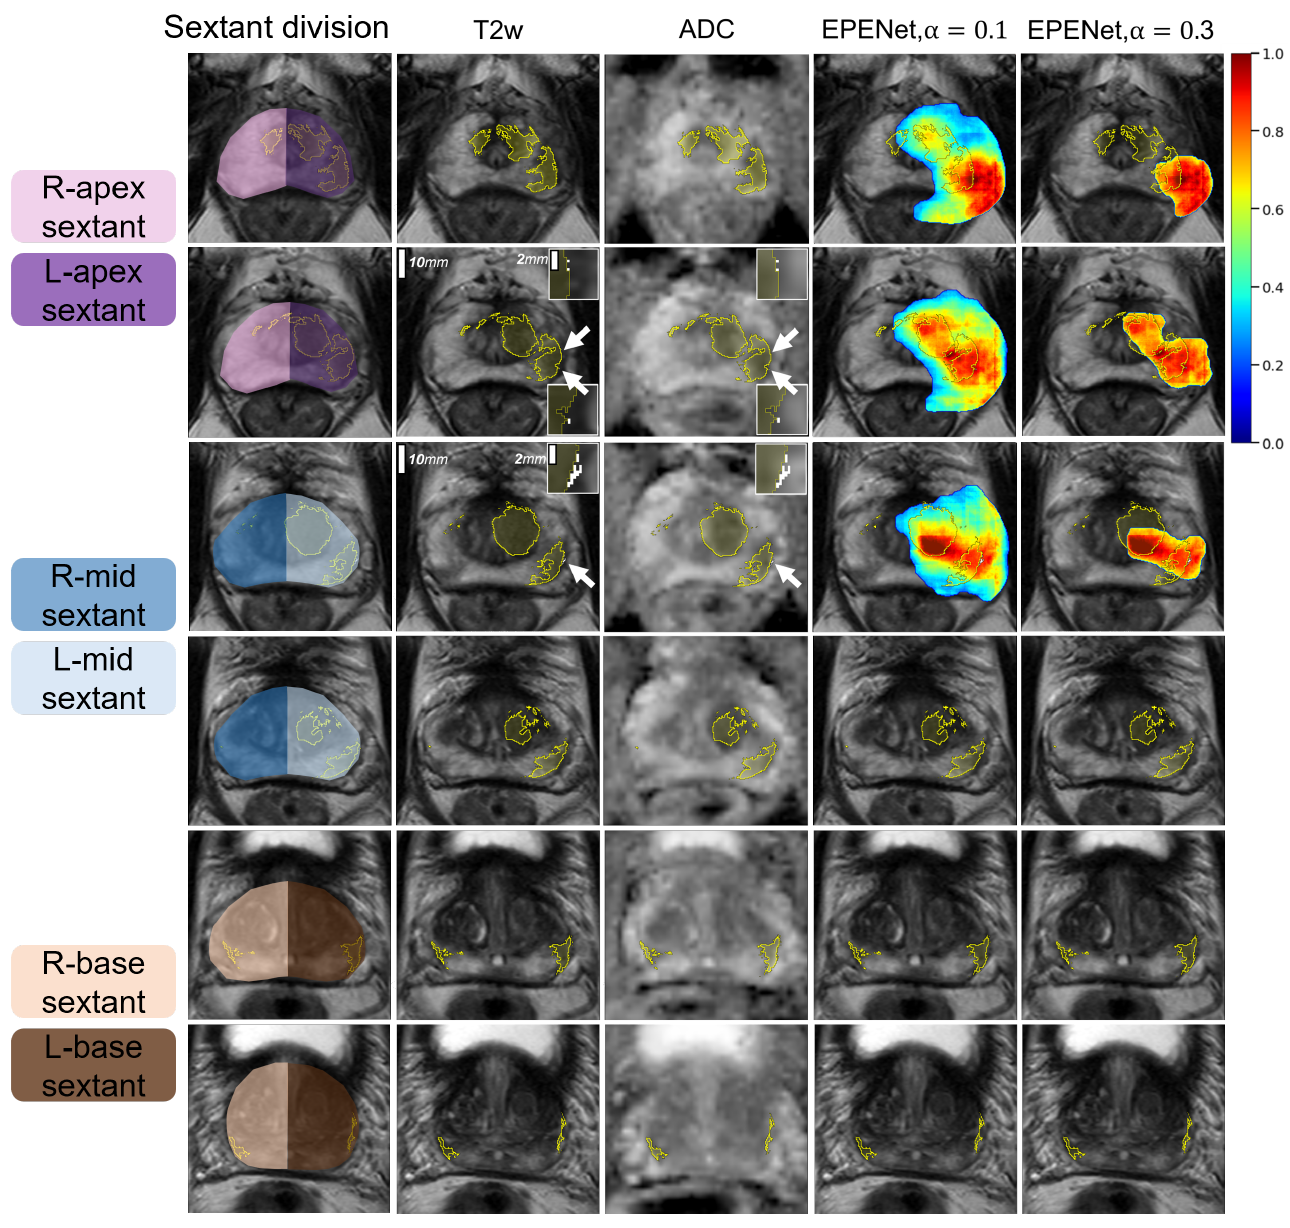
Figure 4. EPENet predictions for cancers with extraprostatic extension in one example case from the test set, from apex to base. EPENet does not show any predictions for cancer lesions fully contained within the prostate capsule. Column (1) Schematic illustration of the prostate division into sextant regions. Column (2) Input T2w images. Column (3) Input ADC images; yellow labels outline cancer within the prostate, white labels outline extraprostatic extension (EPE); white arrows point to the small EPE regions; the panels in the corners show zoomed-in 5 mm × 5mm areas containing EPE. This patient shows cancer on all slices, but EPE is present only in rows 2 and 3. Column (4) and (5) show EPENet predictions for different values of the α parameter. Predictions are probability maps displayed in a cold to hot color scheme (dark blue–0, dark